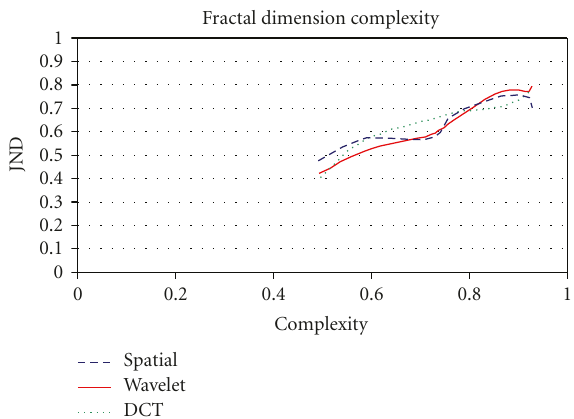
Figure 9: Relation between JND and Fractal complexity measure (averaged on 2000 images).